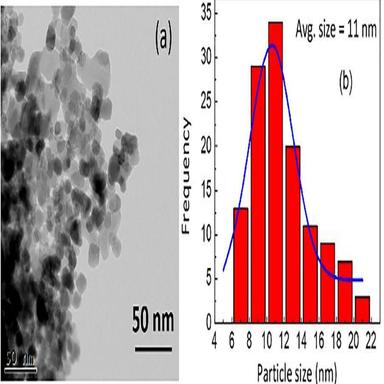
(a) TEM image synthesised Zn0.1Co2.9O4 sample. (b)The corresponding particle size distribution histogram fitted with Gaussian profile function.